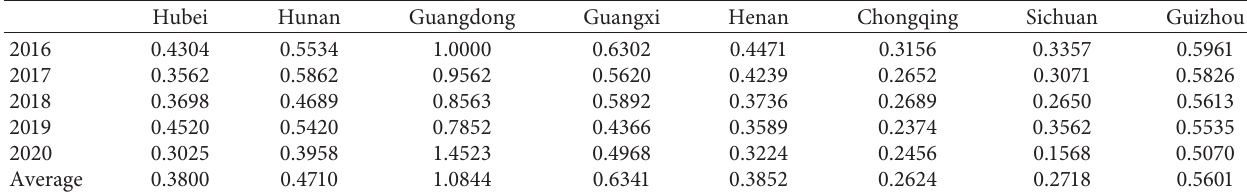
Table 3: Performance evaluation values of the system for workers in the central region.